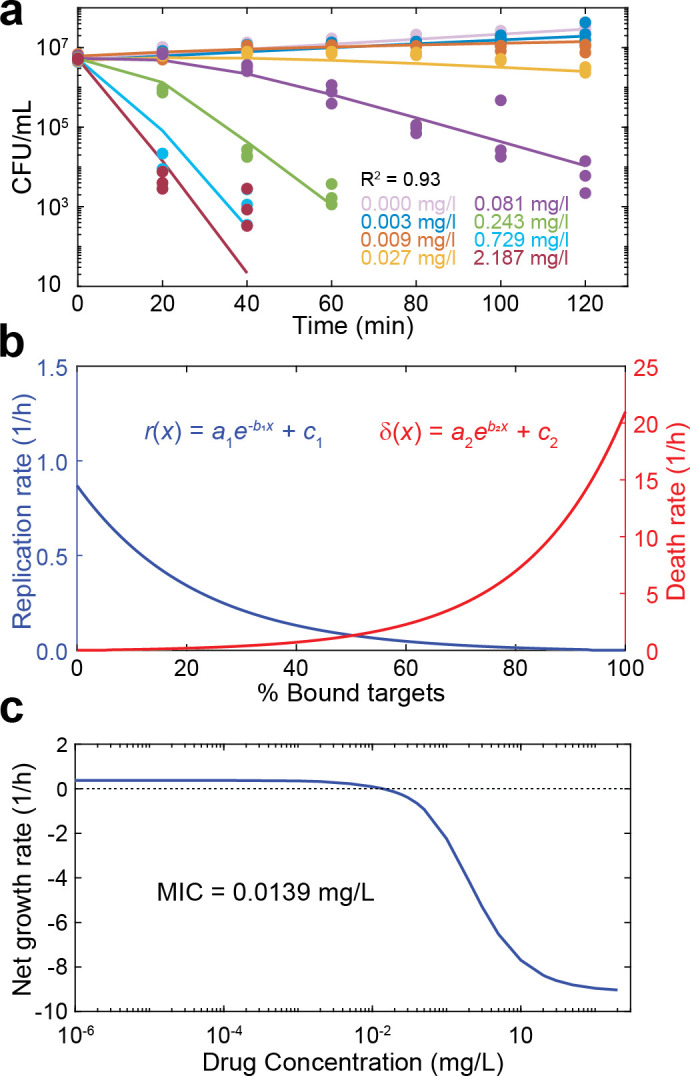
Model predictions for the MIC and the bacteriostatic and bactericidal effects of ciprofloxacin.a, Model fit to experimental time-kill curves. The points indicate the experimental data of three independent replicates, and the lines indicate the model fit. Each color indicates a ciprofloxacin concentration as reported in the figure. b, The blue line indicates the bacteriostatic effect (r(x), replication rate) of ciprofloxacin and the red line the bactericidal effect (δ(x), death rate) as a function of the number of bound targets predicted by the model fit in (a). The values of the fitted parameters are listed in S2 Table. c, The net growth rate as determined by the slope of a line connecting the initial bacterial density and the final bacterial density of a time-kill curve at 18 h on a logarithmic scale, is given as function of the drug concentration (blue). The dotted horizontal line indicates zero net growth, and the intersection with the blue line predicts the MIC (0.0139 mg/mL).